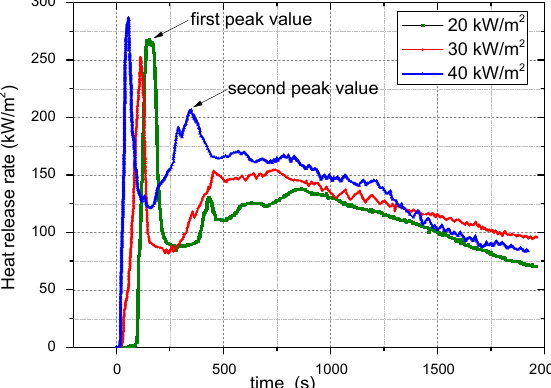
Figure 6. Comparison of HRR curves of XLPE cables under different radiation intensities.